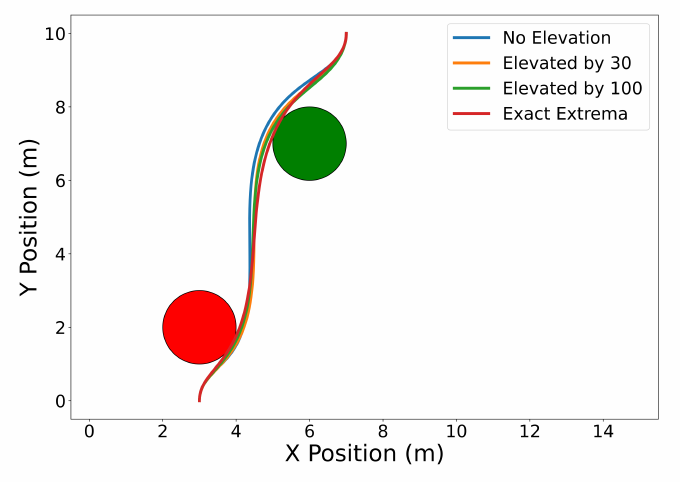
Figure 23. Time optimal trajectory for vehicle with initial and final speeds and headings, maximum speed, maximum angular rate, and maximum safe distance constraints ranging from least to most conservative distance estimates.